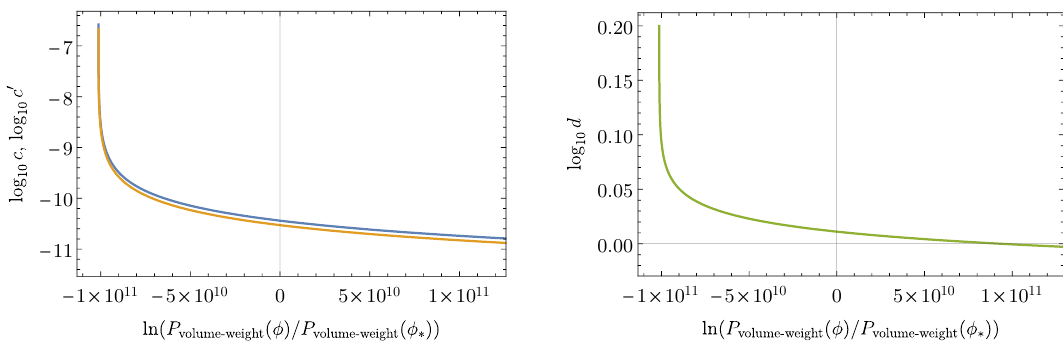
Figure 7. The maximum values of the parameters in the Swampland conjectures as a function of (the logarithm of) the conditional probability density P volume-weight ( (cid:30) ) at the point (cid:30) where the Swampland inequality is saturated, normalized by the probability density P volume-weight ( (cid:30) (cid:3) ) at the point (cid:30) (cid:3) where the saddle-point solution disappears. In both panels, (cid:11) = 1 and V 0 = 2 : 0 (cid:2) 10 (cid:0) 9 , and the slow-roll formula for the e-folding number is assumed. (Left) The parameters of the (re(cid:12)ned) dS conjecture c (blue line; upper) and c 0 (orange line; lower). (Right) The parameter of the distance conjecture d